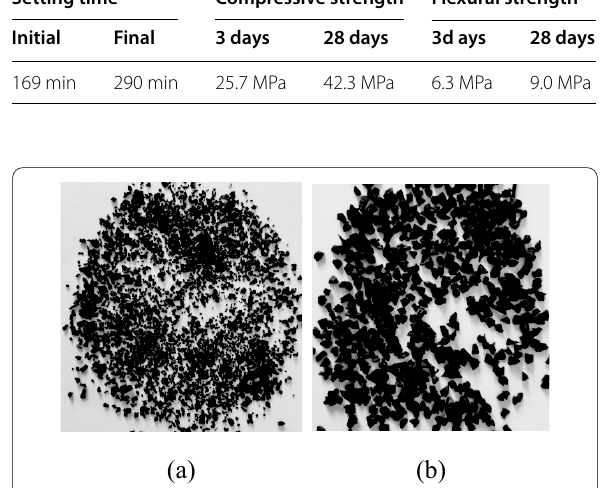
Fig. 1 Photographs of the RPSs with a diameter of a 1–3 mm and b 3–5 mm.